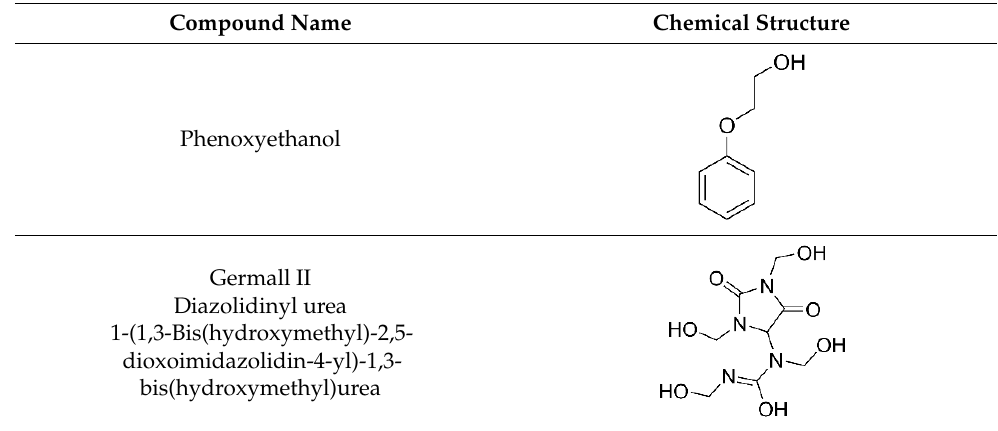
Table 1. Structures of used compounds in the study.